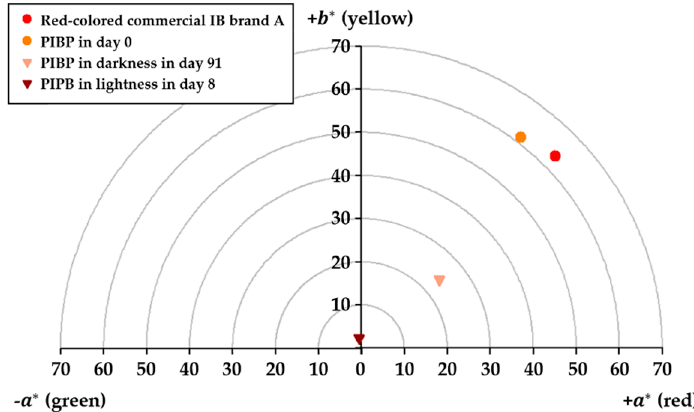
Figure 4. Top of the color sphere, quadrants first and second showing the locations of red-colored commercial isotonic beverages (IB) of brand A, and prototype pigmented isotonic beverages (PIBP) in its three conditions, at time 0, stored in light stress and stored in darkness.